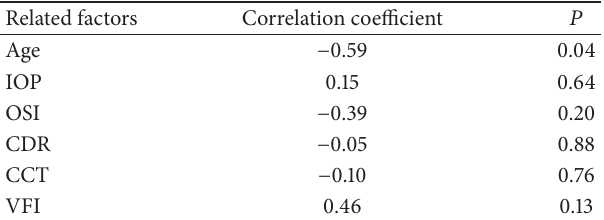
Table 3: Related factors in MTF